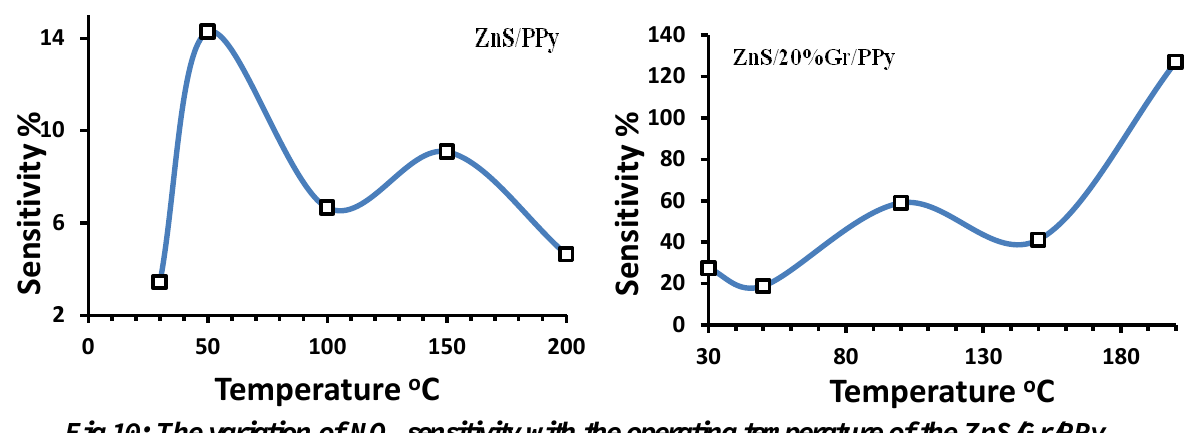
Fig.10: The variation of NO sensitivity with the operating temperature of the ZnS/Gr/PPy 2 with different ratios of ZnS/Gr thin